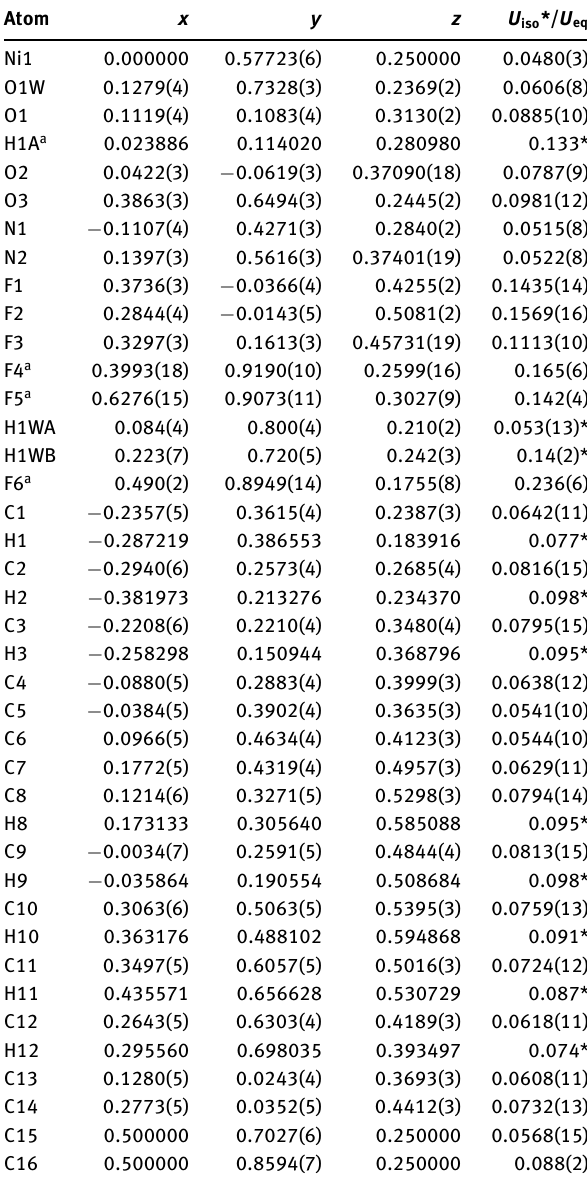
Table 2: Fractional atomic coordinates and isotropic or equivalent isotropic displacement parameters (Å 2